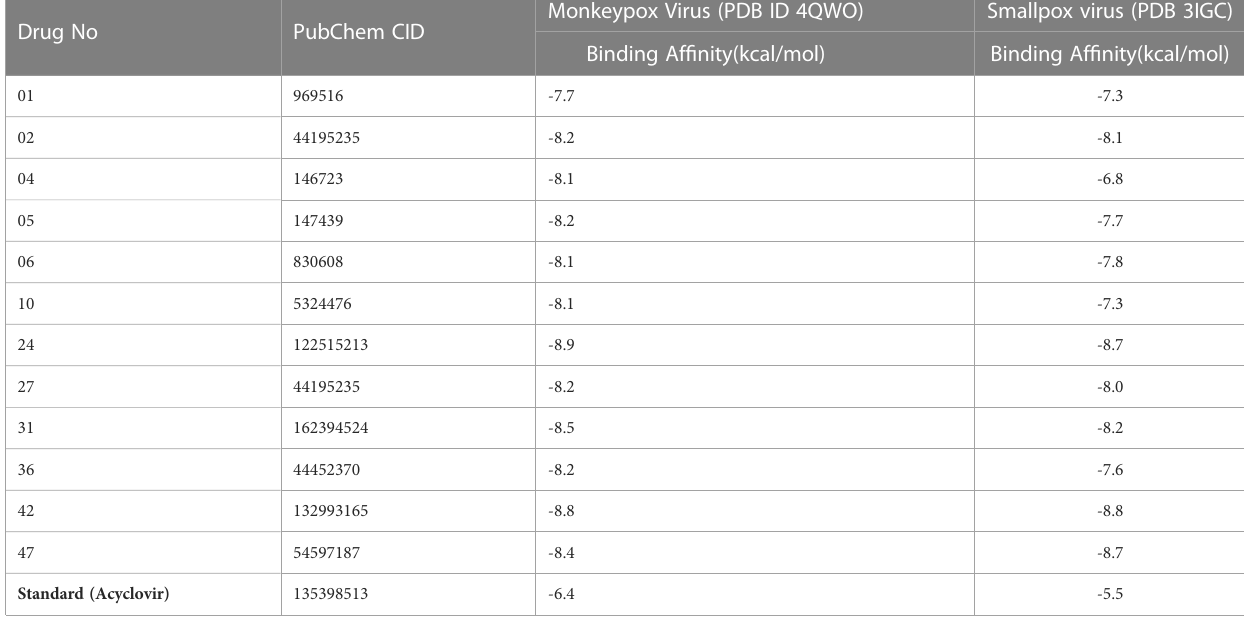
TABLE 3 Summary of binding af fi nities against Monkeypox, and Smallpox